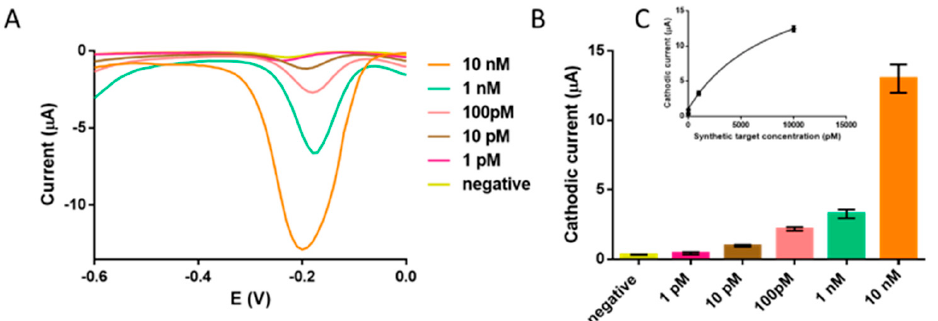
Figure 7. ( A ) Voltagramms for the RCA on MPs and electrochemical genosensing based on direct labelling, performed by isothermal amplification of 16S ribosomal E. coli synthetic target ranging from 1pM to 10 nM, and including the negative controls. All other conditions as Figure 6. ( B ) Calibration plot of the SWV maximal signal. The bars represent the mean value, and the error bars, the SD for n = 3. ( C ) Fitted SWV signals by a nonlinear regression, nonlinear regression (Two site binding –hyperbola). The negative controls are also shown (n = 6).